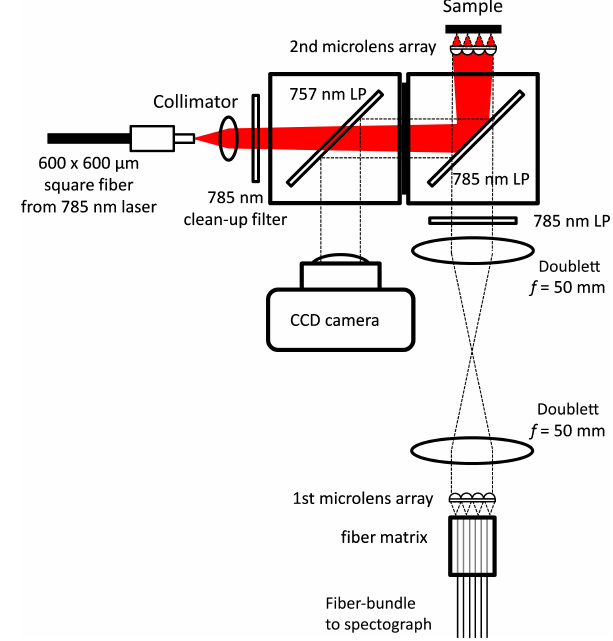
Figure 5. Design of the microlens-based image acquisition optic AO2 suitable for a square image field with 1cm side